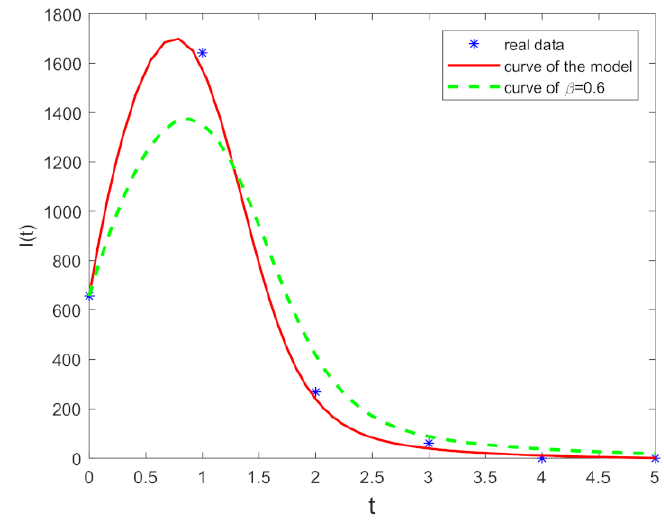
Figure 8. Time series diagram of t-I based on the rumor